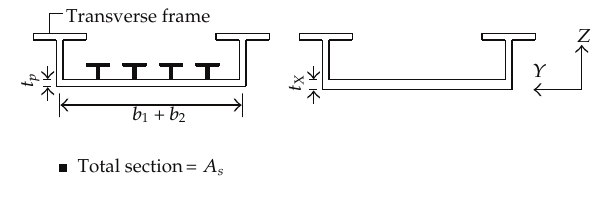
Figure 13: Equivalent plate